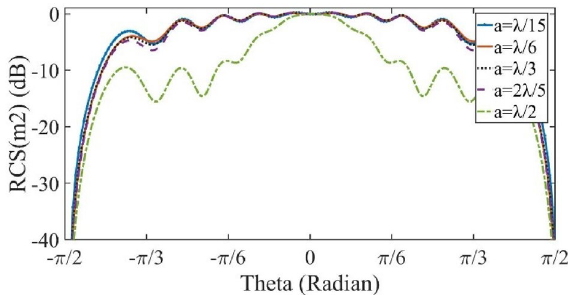
Figure 8. The flat-top pattern in dB for different values of cell-cluster dimensions.